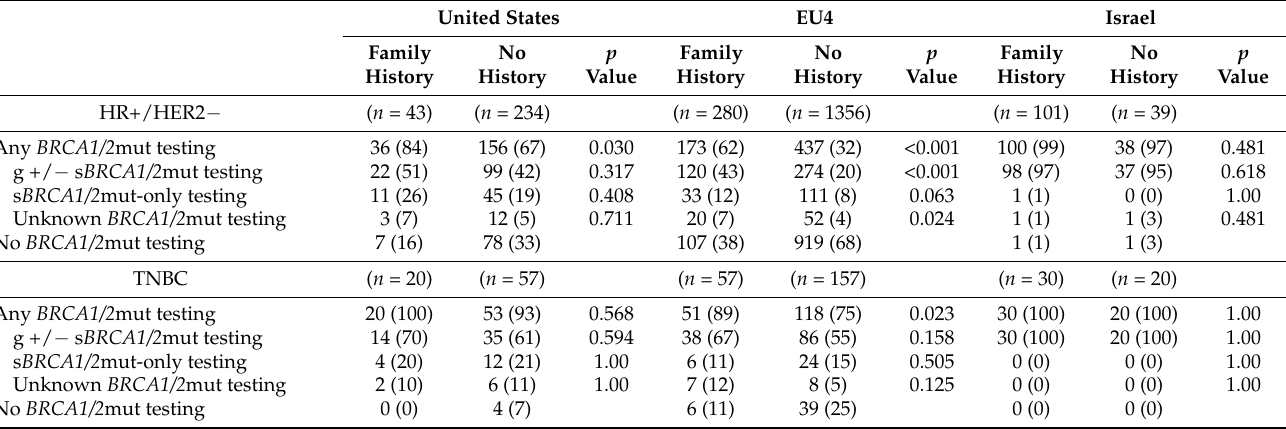
Table 4. BRCA1/2 mut testing rates by family history of BRCA1/2 -related cancer * among patients with HER2– ABC in the United States, the EU4, and